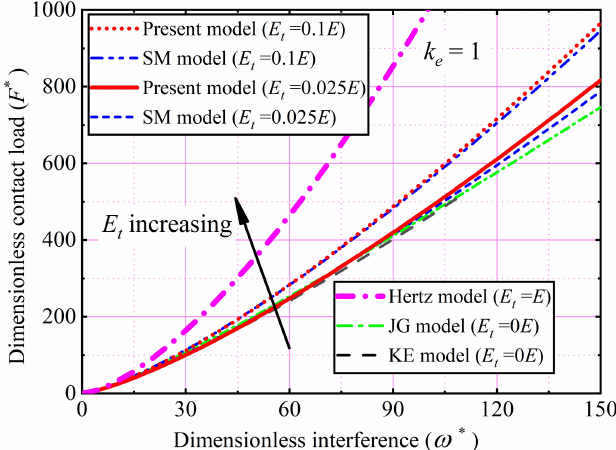
Figure 11. Comparisons of F * predicted by the present and previous models at k e = 1.